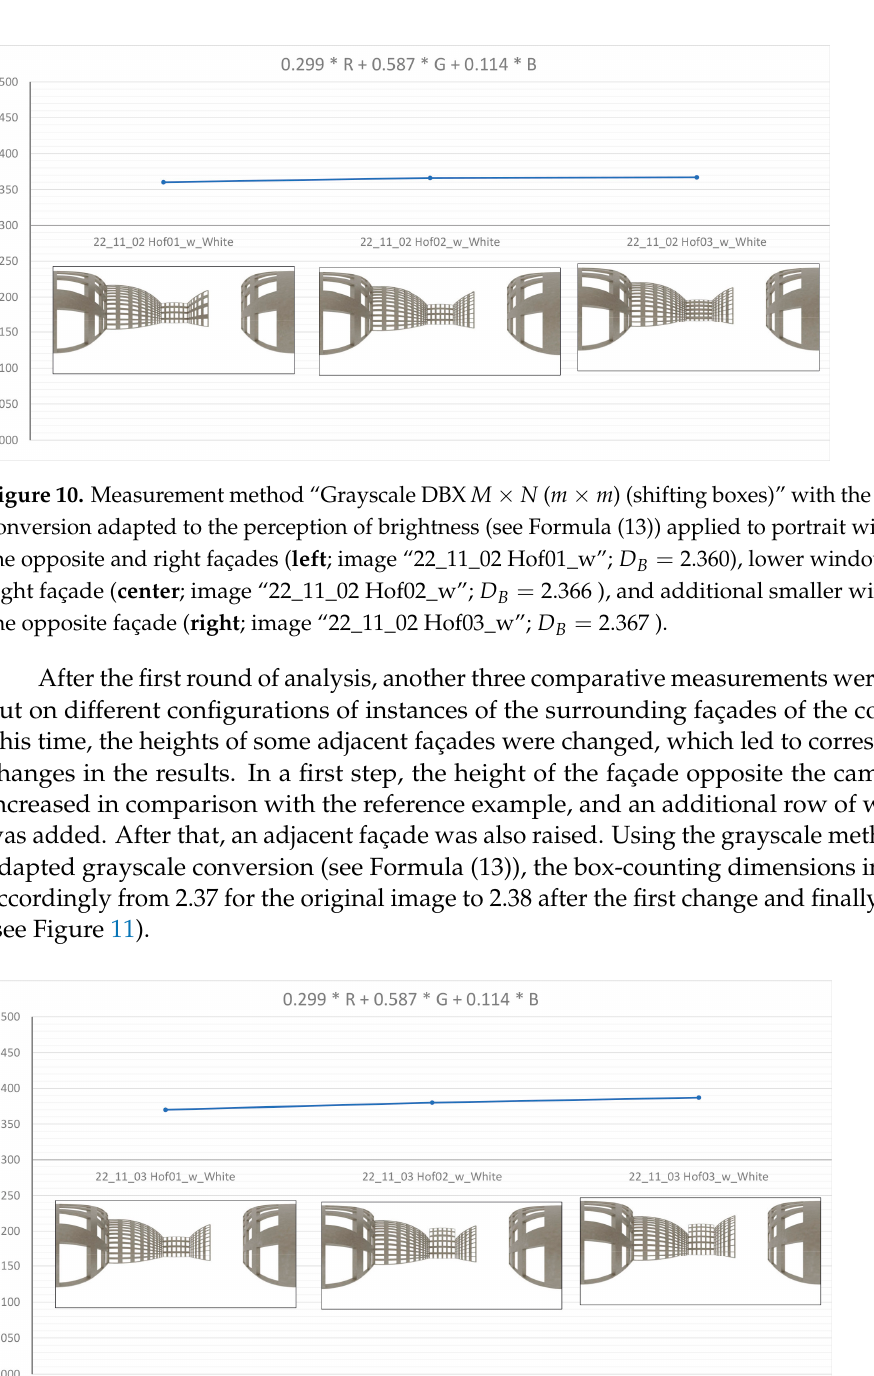
Figure 11. Measurement method “Grayscale DBX M × N ( m × m ) (shifting boxes)” with the grayscale conversion adapted to the perception of brightness (see Formula (13)) applied to different heights of the opposite and right façades ( left : image “22_11_03 Hof01_w_White”, D B = 2.370; center : image “22_11_03 Hof02_w_White”, D B = 2.380; right : image “22_11_03 Hof03_w_White”; D B = 2.387 ).